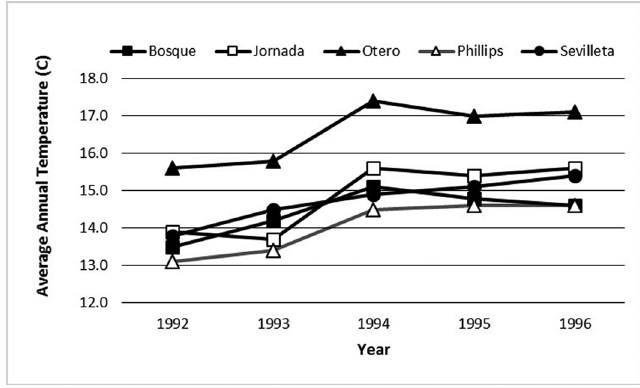
Fig. 2. Annual average (12 months/year) temperatures at each of the study sites over the five-year study